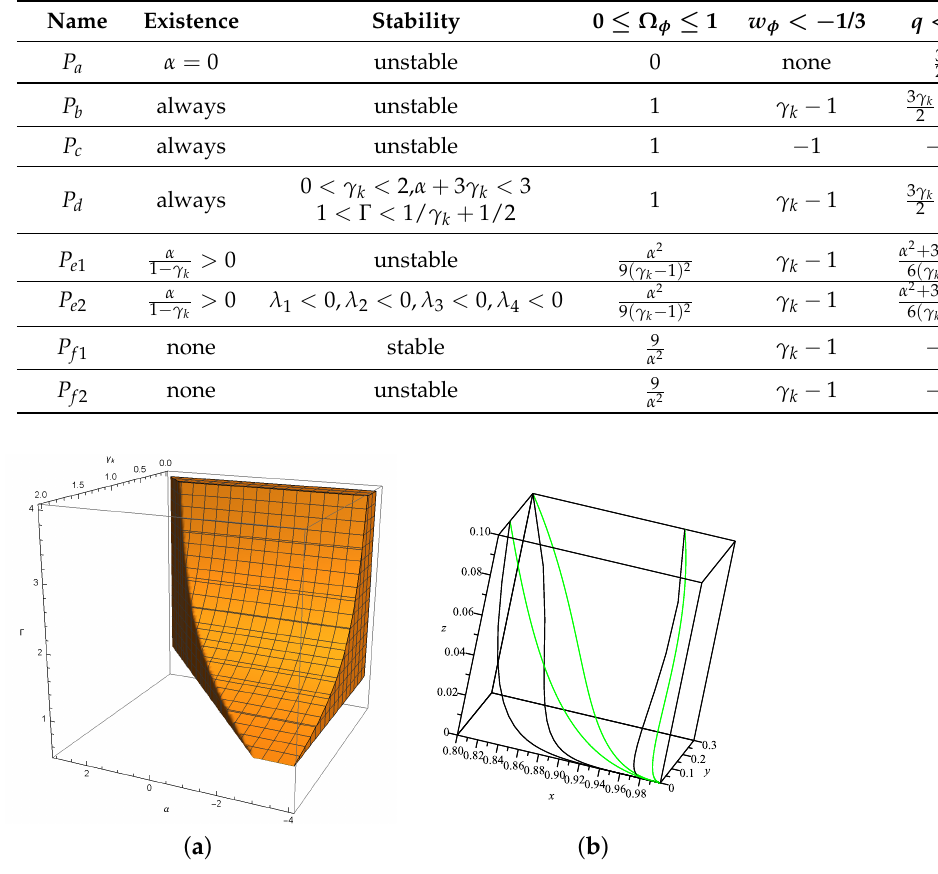
Figure 8. ( a ) The value ranges for parameters α , γ k and Γ to create and stabilize the critical point P d ; ( b ) The 3-dim phase space for fixed γ k = 8 α = − 1 (black) and α = − 2 (green) around P d = ( 1,0,0, 30